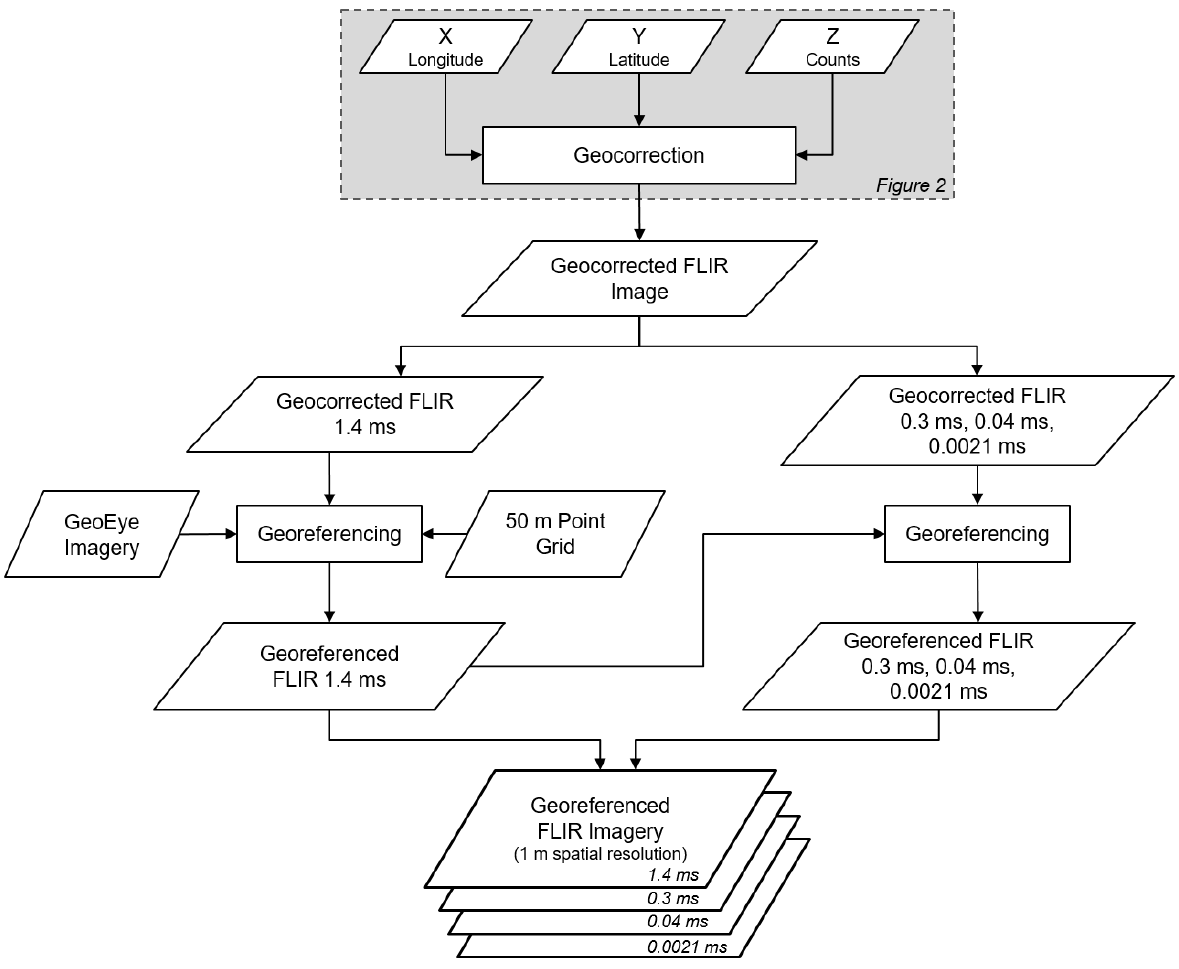
Figure 7. Workflow displaying the georeferencing methodology developed to reduce the geolocation error of the acquired FLIR data.